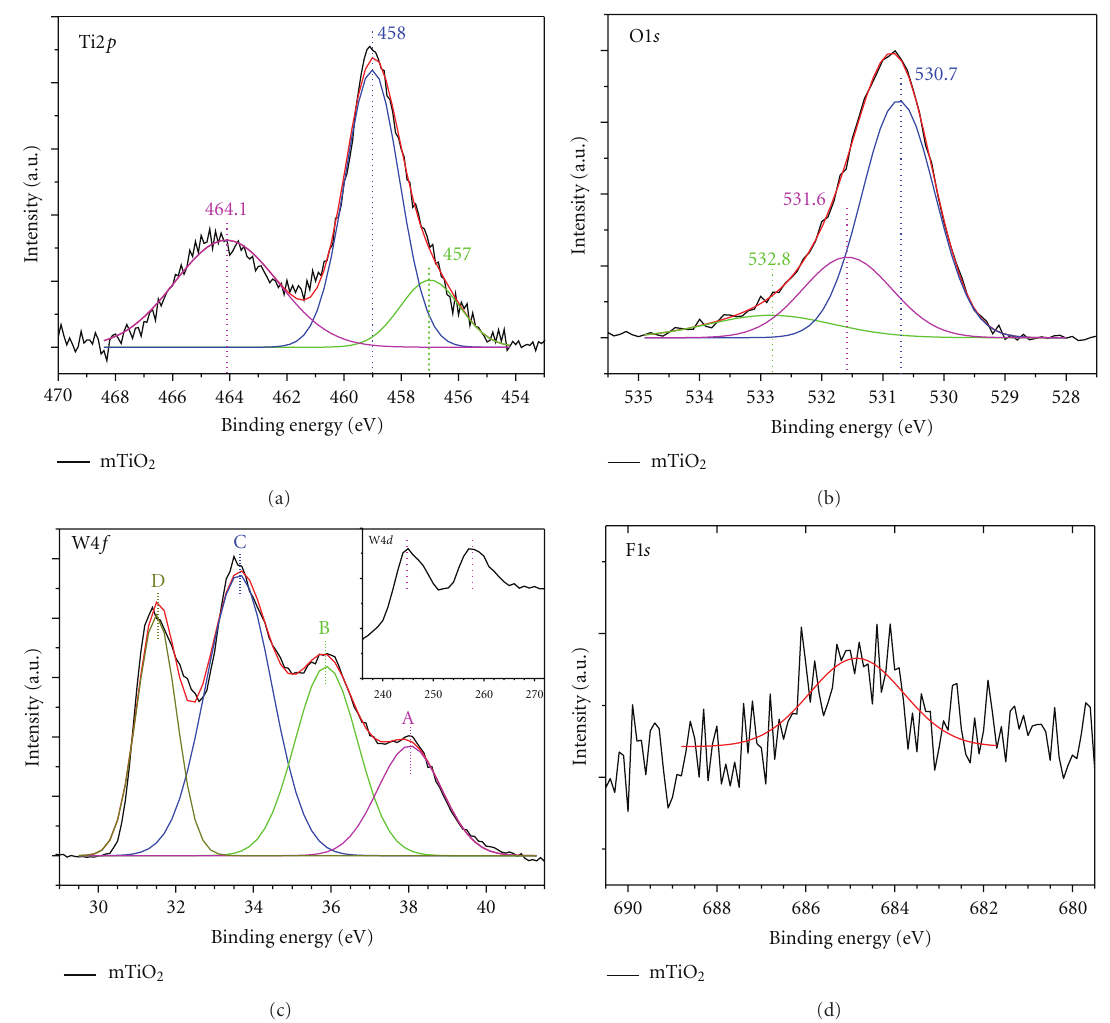
Figure 3: High resolution XPS spectrum of: (a) Ti2p, (b) O1s, (c) W4f/Wd, and (d) F1s core levels of the mTiO 2